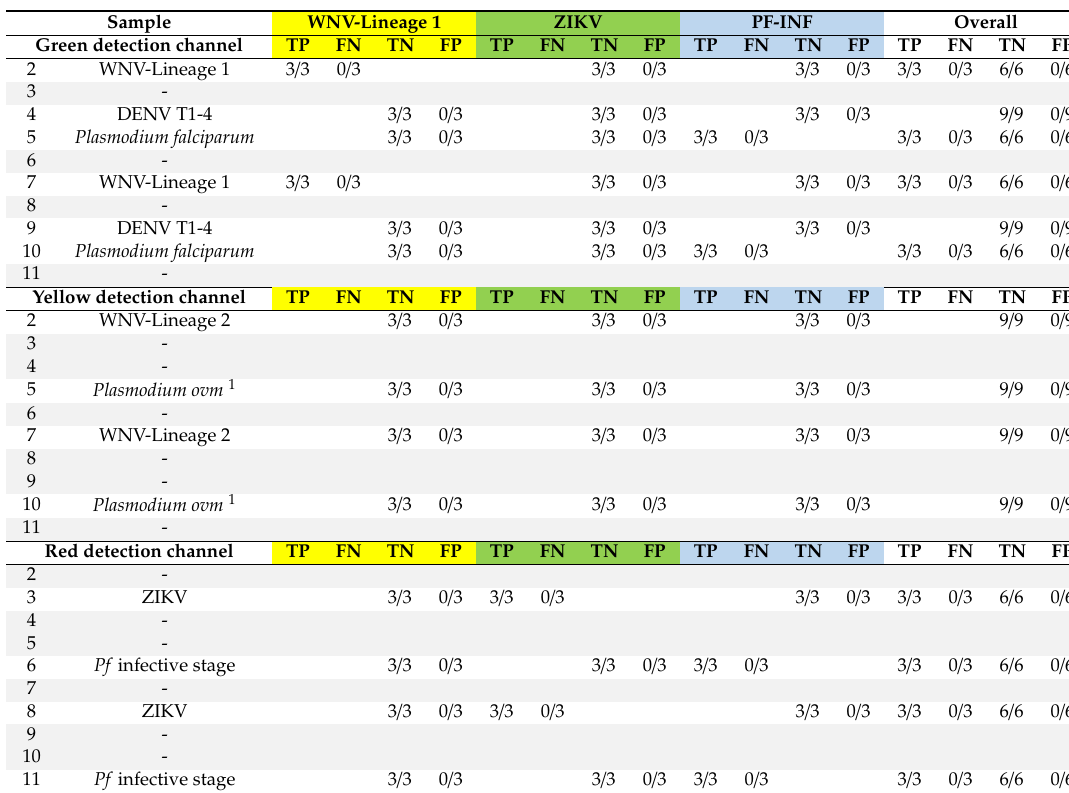
Table 4. Overview of the true positive (TP), false negative (FN), true negative (TN), and false positive (FP) rates for each assay and for each sample, as well as in total for the NA study. The numbering in the first column indicates the VectorDisk reaction chamber where an assay is expected positive or negative. The grey horizontal shading in some assay rows (accompanied by the symbol ‘-’) means that neither positive nor negative signal was expected, because the primer / probe mixtures stored in these chambers were expected to give signals in other detection channels. The coloring of the columns